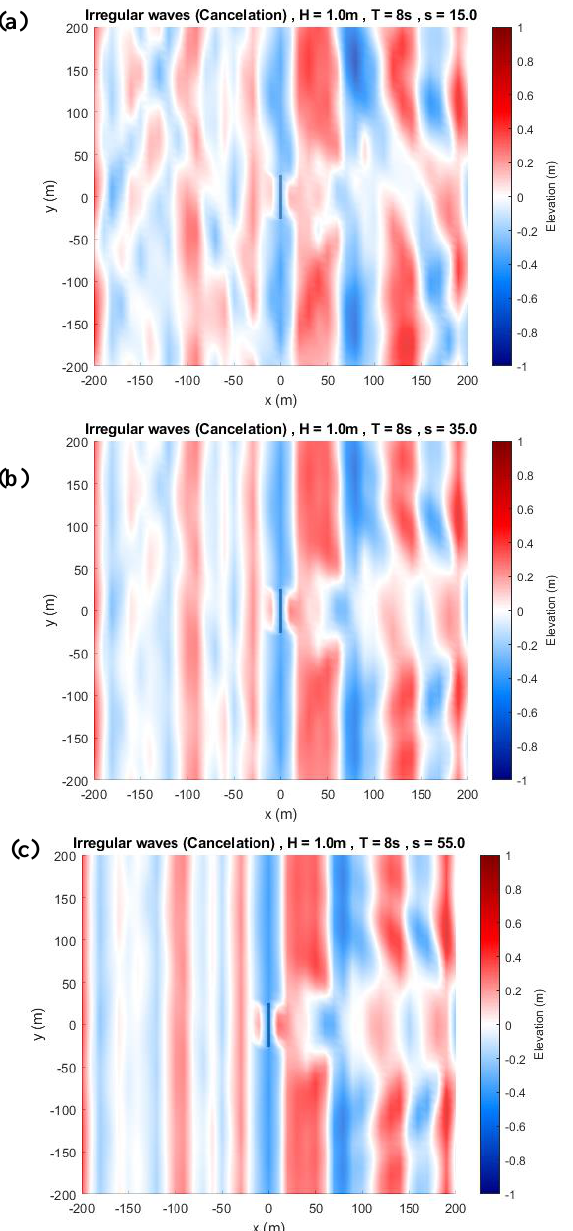
Figure 11: The instantaneous free surface elevation of the wave field for short crested wave conditions for different spreading indexes of, (a) 𝑠𝑖 = 15 , (b) 𝑠𝑖 = 35 , and (c) 𝑠𝑖 = 55 with 𝑠 𝜆⁄ = 0.5 .